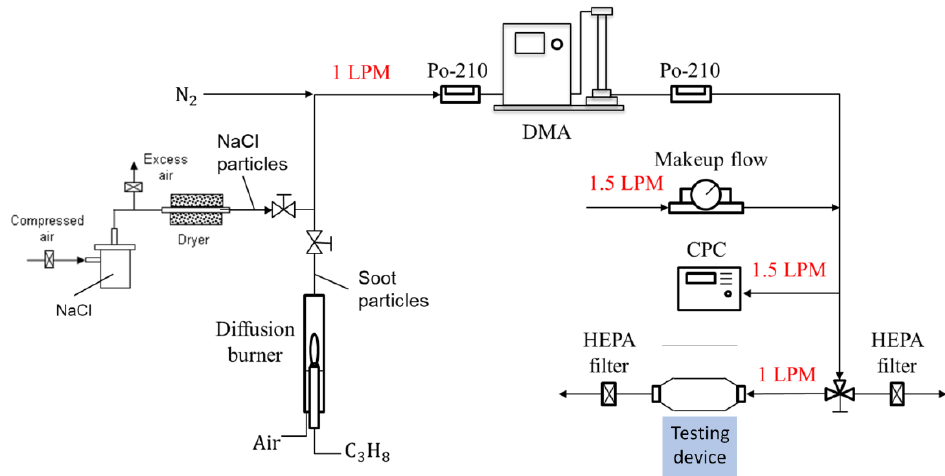
Figure 3. A particle calibration system using monodisperse NaCl and soot particles for evaluating the ability to detect airborne nanoparticles.